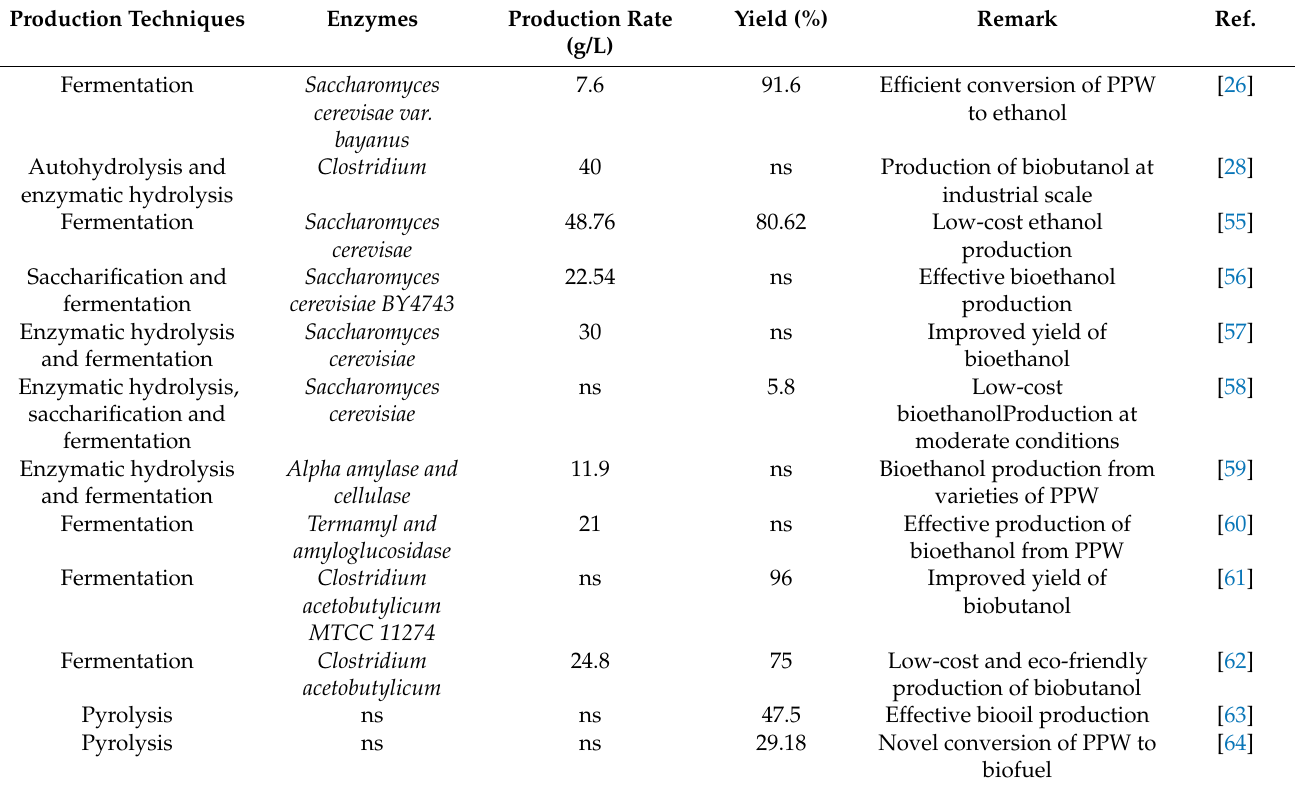
Table 3. Application of PPW for